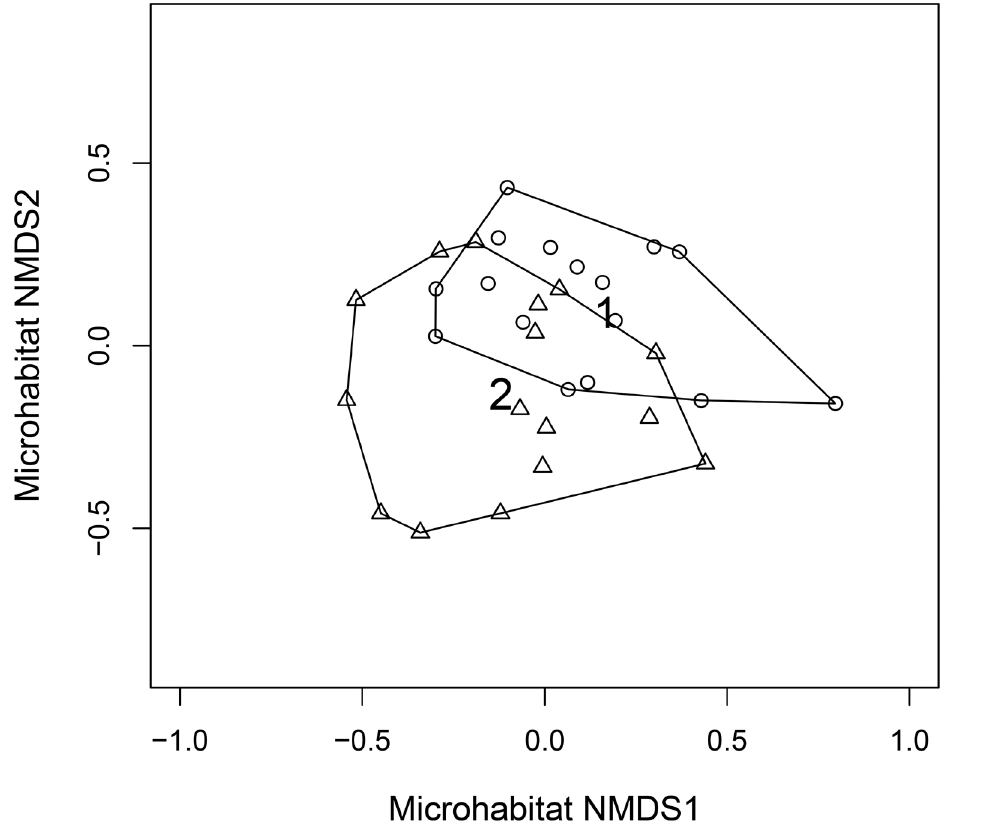
Figure 2. A non-metric multidimensional scaling (NMDS) using Bray-Curtis distance to summarize microhabitat condition data, showing two hulls representing belt transects (1, circle) close to and (2, triangular) far from the main stream. Stress value for first two axes = 0.17. Table 1. Effect of Microhabitat NMDS1 and NMDS2 and proximity to main stream on total abundance of pygmy grasshoppers. Mar-